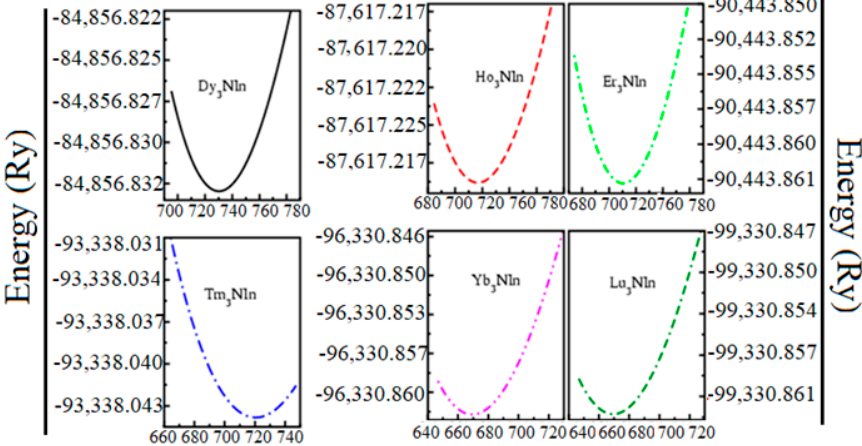
Figure 3. Energy versus volume optimization curve of the rare earth nitrides Ln 3 NIn (Ln = Dy-Lu) anti-Perovskite. Table 1. The lattice constant, cohesive energy, enthlopy of formation and ground state energy of